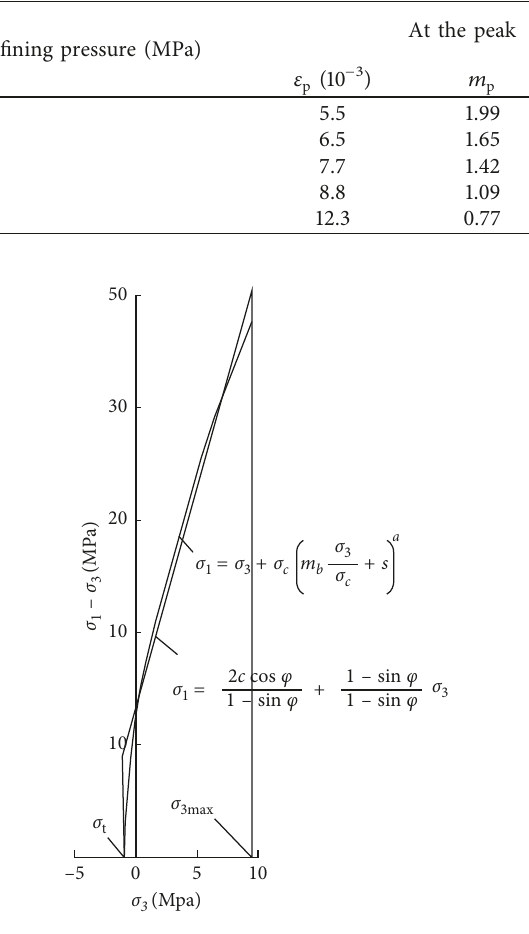
Figure 6: Relationships between the minimum and maximum principal stresses for equivalent Hoek–Brown and Mohr–Coulomb criteria [29].